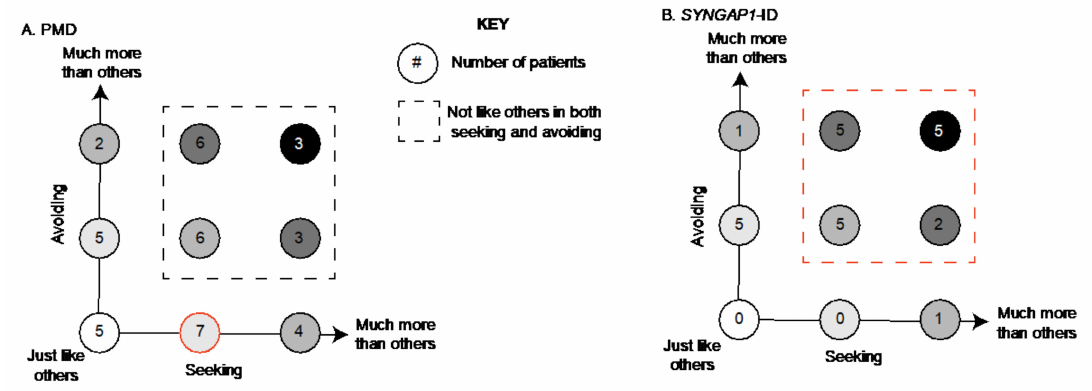
Figure 3. Association between seeking and avoiding scores. Number of ( A ) PMD and ( B ) SYNGAP1 - ID patients with each possible combination of seeking ( x -axis) and avoiding ( y -axis) scores. Each circle indicates a possible combination and is color coded based on severity. For example, white circle indicates patients scoring in the expected range for both areas, with darker shading indicating higher scores. Subjects scoring outside the expected range in both categories indicated by dashed box. Most common combinations highlighted in red. PMD: Phelan-McDermid Syndrome. SYNGAP1-ID: SYNGAP1-related Intellectual Disability. SSP-2: Short Sensory Profile-2.